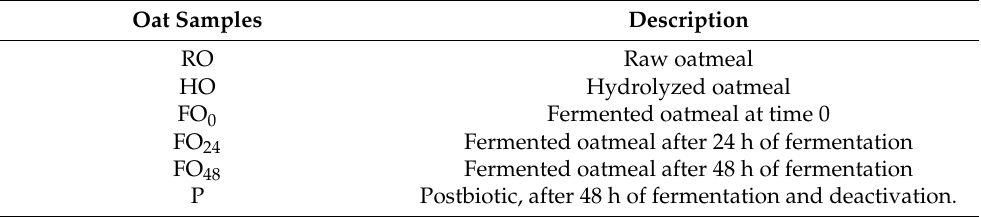
Table 1. Description of the investigated samples.